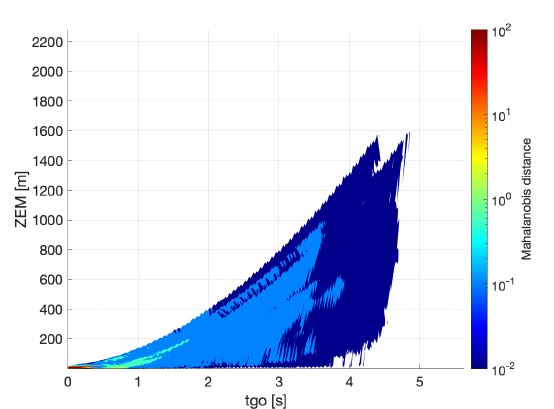
Figure 7. d M ( ZEM ) calculated with CRLB—Bearings only measurement.